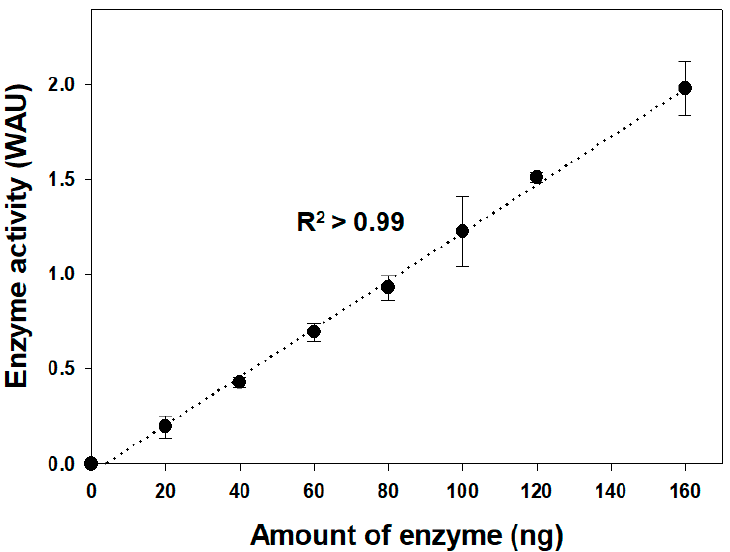
Figure 3. Experimental validation of the assay. The direct proportionality between the amount of enzyme and the measured activity is shown. Error bars represent standard deviations from two independent experiments.